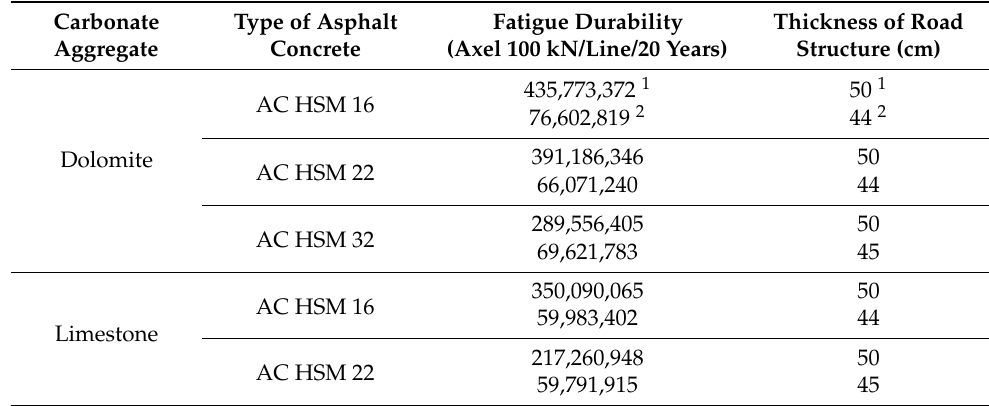
Table 5. Fatigue durability and thickness of road surface structure: 1 —according to GDDKiA Catalogue; 2 —according to the studies presented herein (see Figure